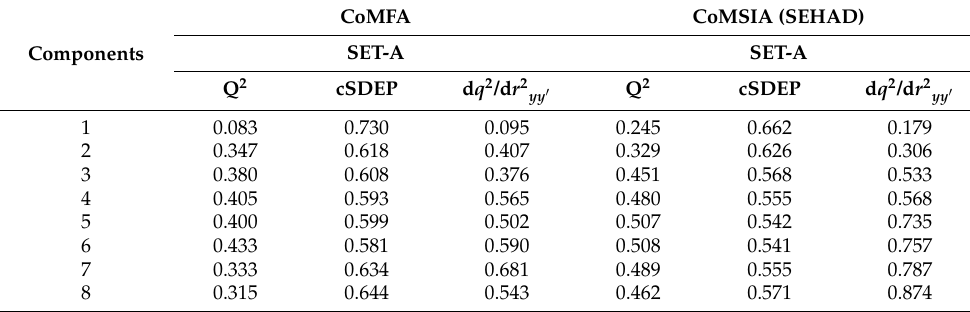
Table 9. Progressive scrambling results from the CoMFA and CoMSIA of PI3K γ